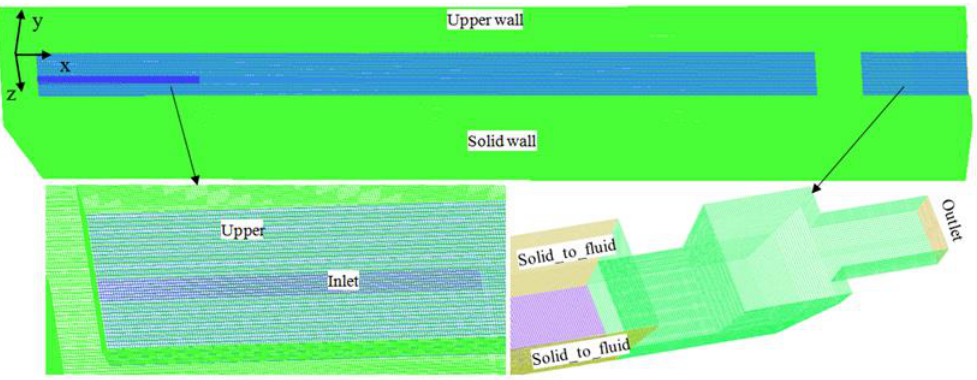
Figure 2. Computational grids of the main trough.